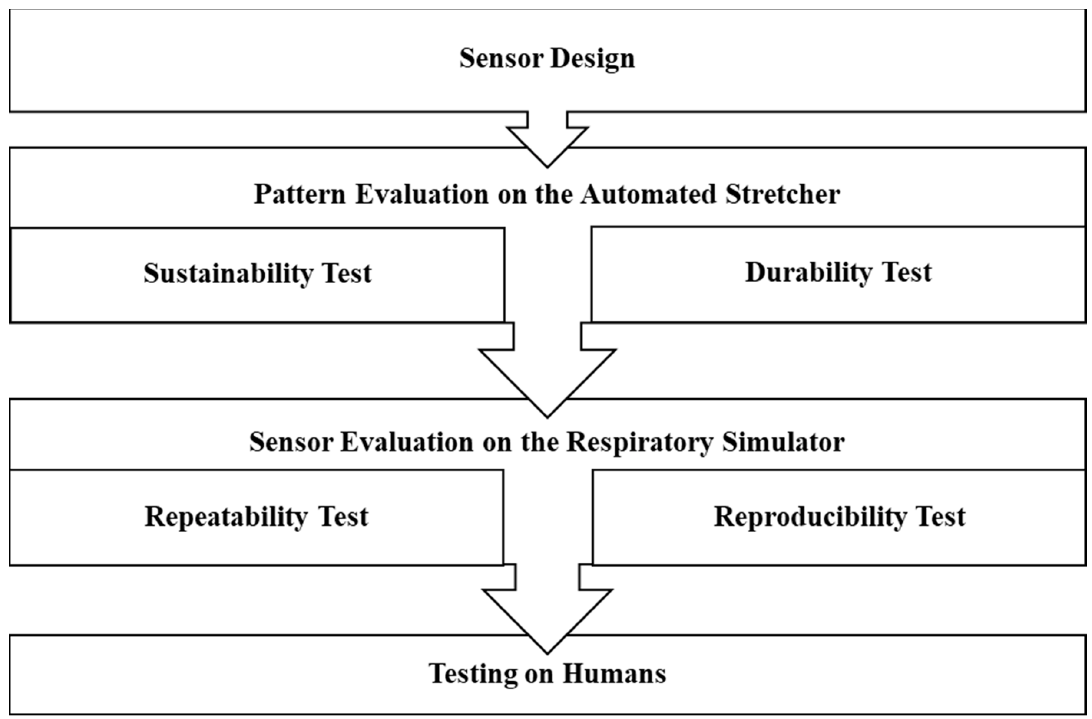
Figure 1. Development procedure for the fabrication and evaluation of the respiration rate (RR)sensor.